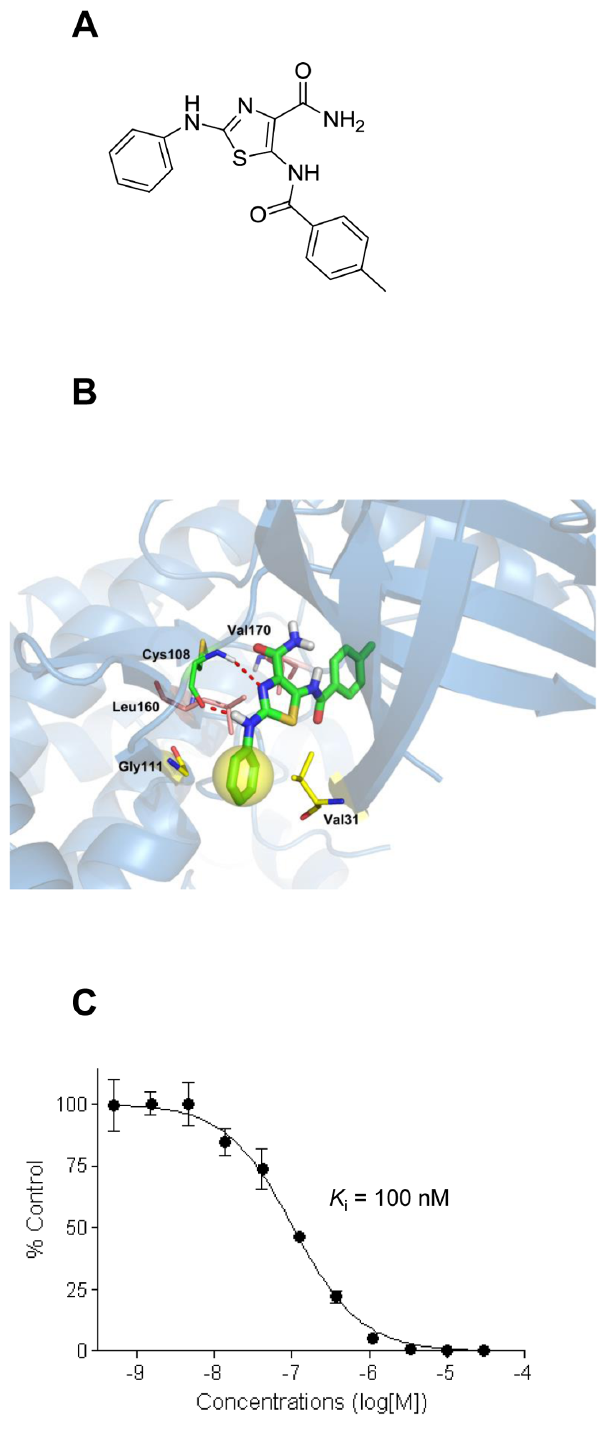
Figure 1. Binding mode and K i of KY-05009 for TNIK. (A) Chemical structure of KY-05009. (B) Binding mode of KY-05009 for TNIK. KY-05009 has two H-bond interactions with Cys108 (red dotted lines) in the hinge region, and CH/ p interactions with Val31, Gly111, and Leu160. The yellow ball represents the CH/ p interactions among Val31, ligand, and Gly111. (C) The binding constant, K i , of KY-05009 for TNIK was determined using an ATP competition assay.